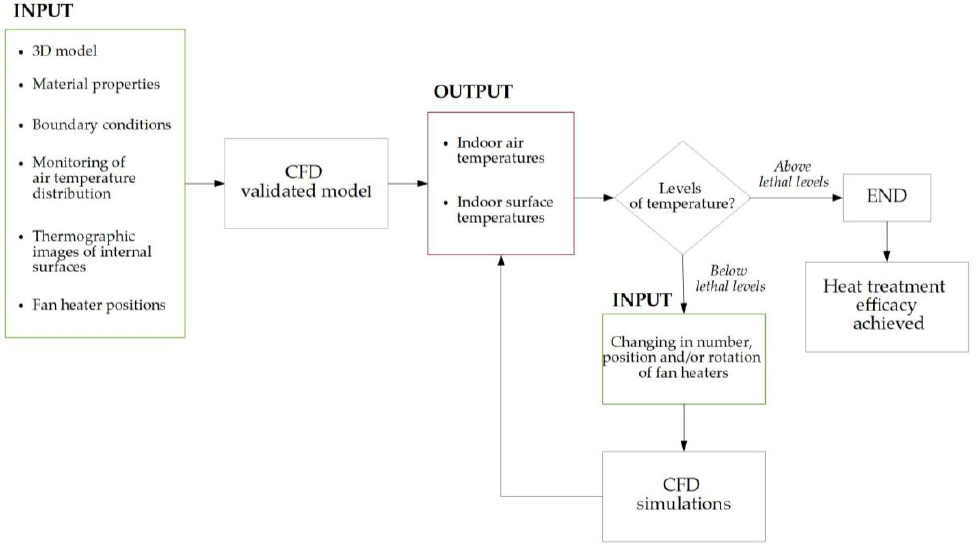
Figure 2. Flow diagram of the proposed method.